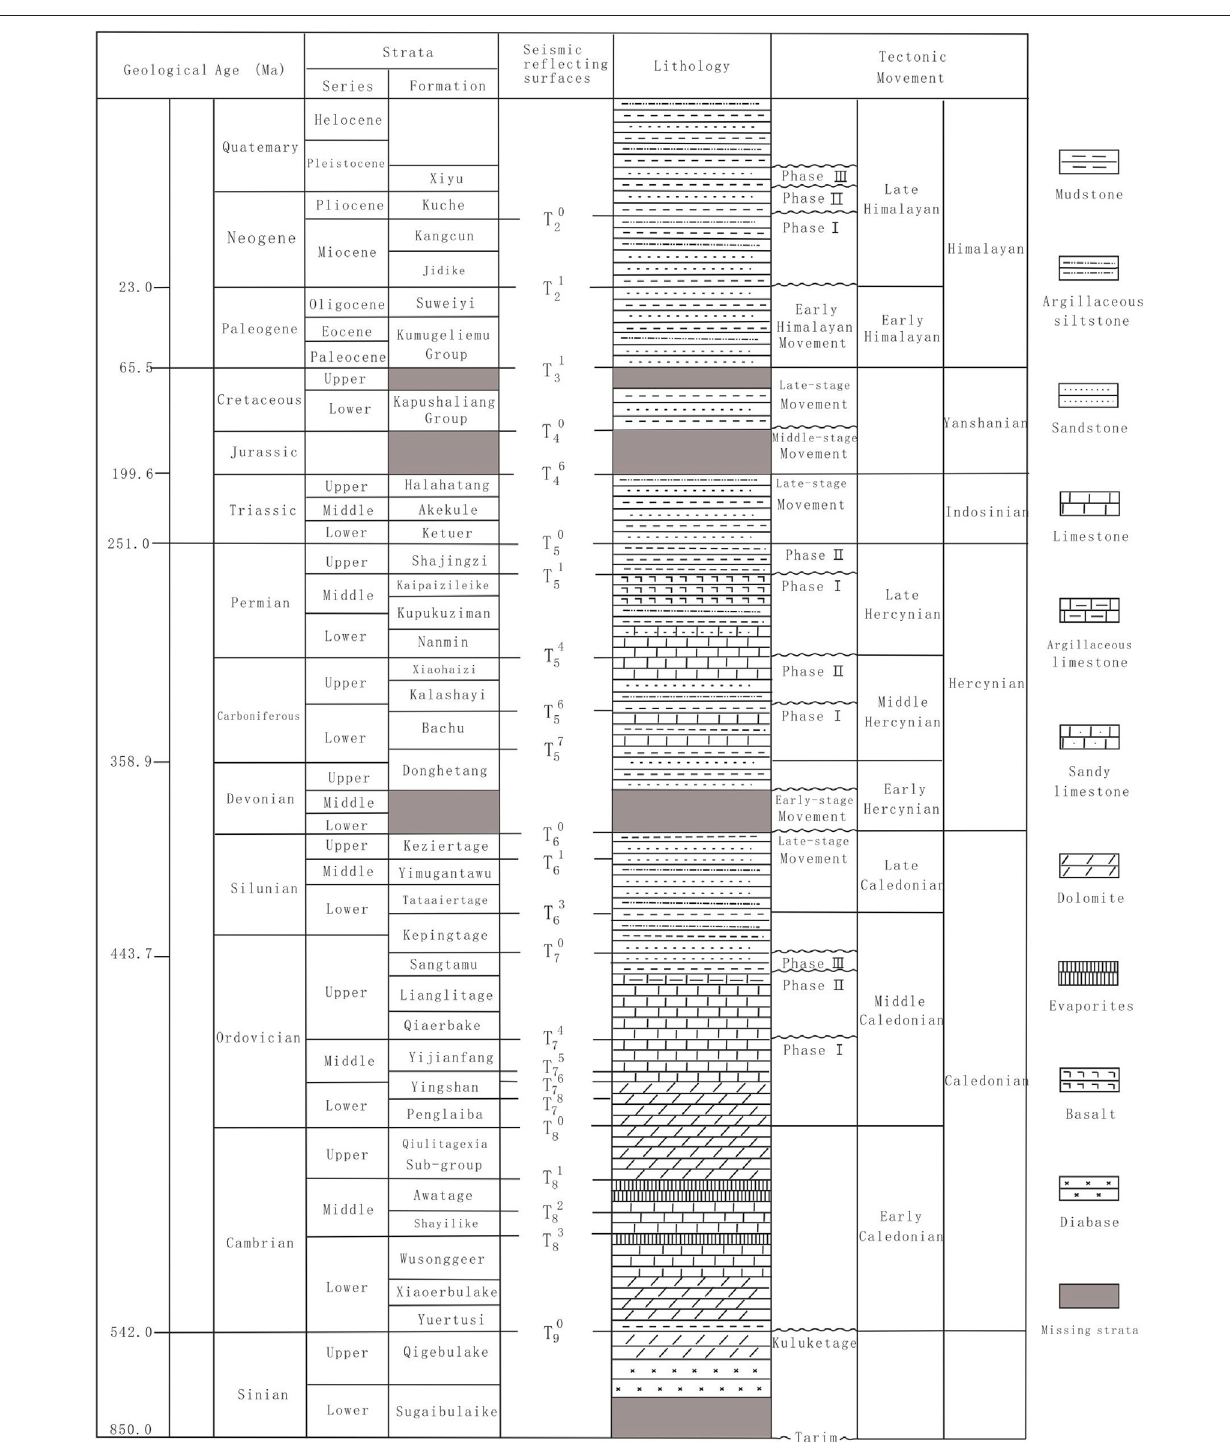
Frontiers in Earth Science |